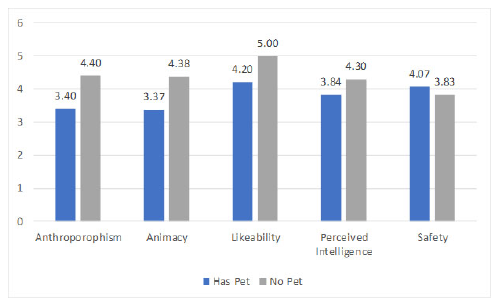
Figure 3: Average Godspeed scores for participants with and with- out pets. Scores range from 1 to